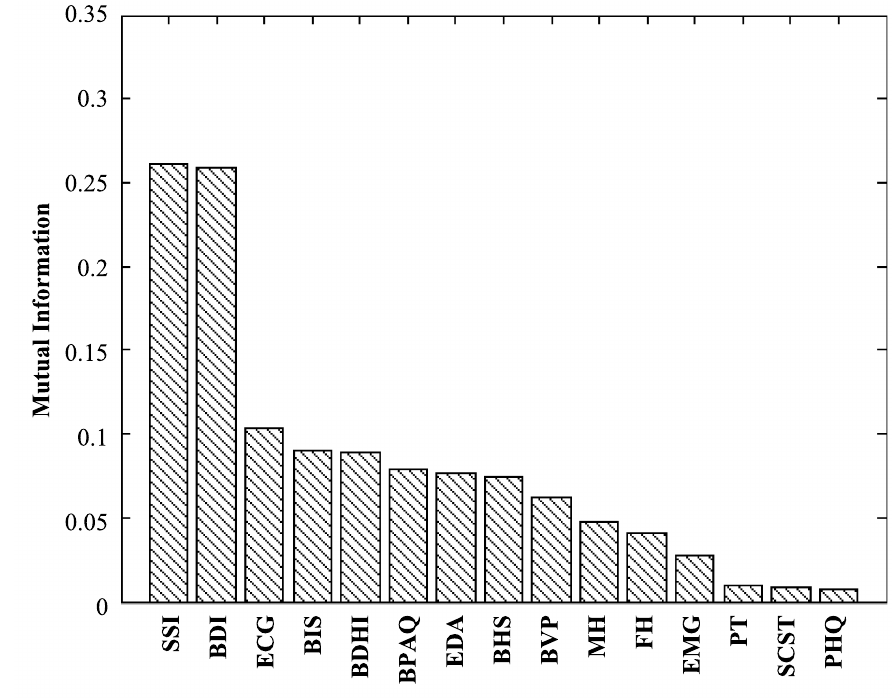
Figure 8. Discriminating feature groups based on mRMR. The cumulative mutual information of different features of Scale of Suicide Ideation (SSI) [30], Beck Depression Inventory (BDI) [10], Electrocardiogram (ECG), Baratt’s Impulsiveness Scale (BIS) [28], Buss-Durkee Hostility Inventory (BDHI) [29], Buss-Perry Aggression Questionnaire (BPAQ) [27], Electro-Dermal Activity (EDA), Beck Hopelessness Scale (BHS) [15], Blood Volume Pulse (BVP), patients’ Medical History (MH), patients’ Family History (FH), Electromyography (EMG), Personal Traits (PT), Stress and Coping Self-Test (SCST) [45] and Patient Health Questionnaire (PHQ) [20] are presented for the feature